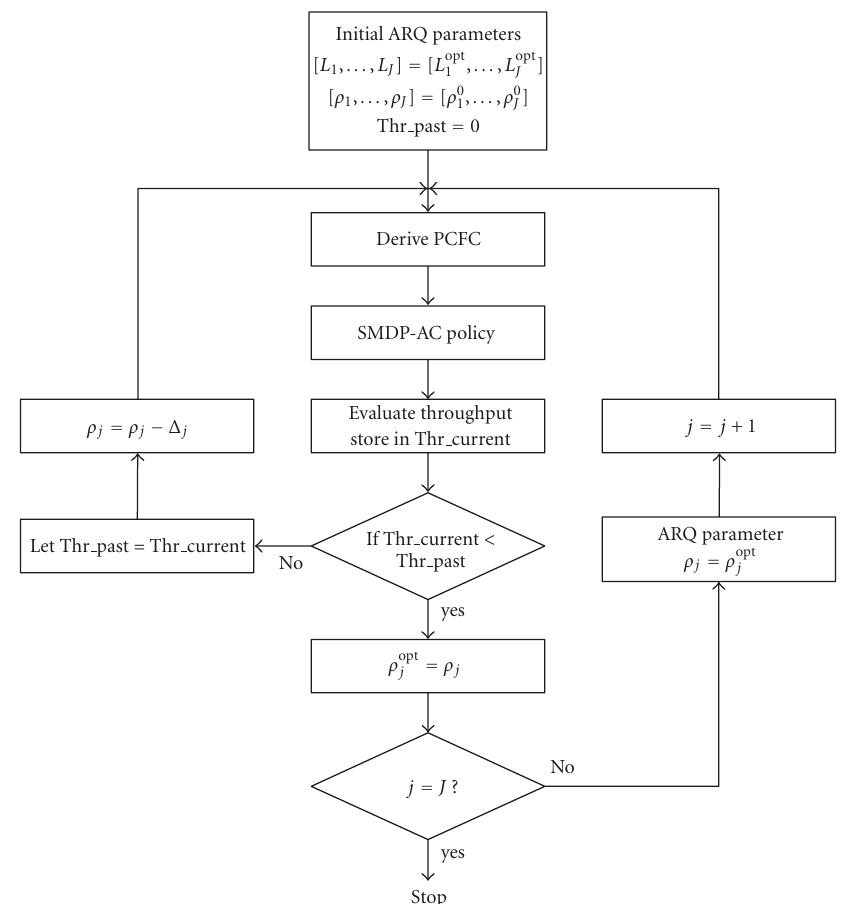
Figure 2: Search procedure of the optimal target PER.